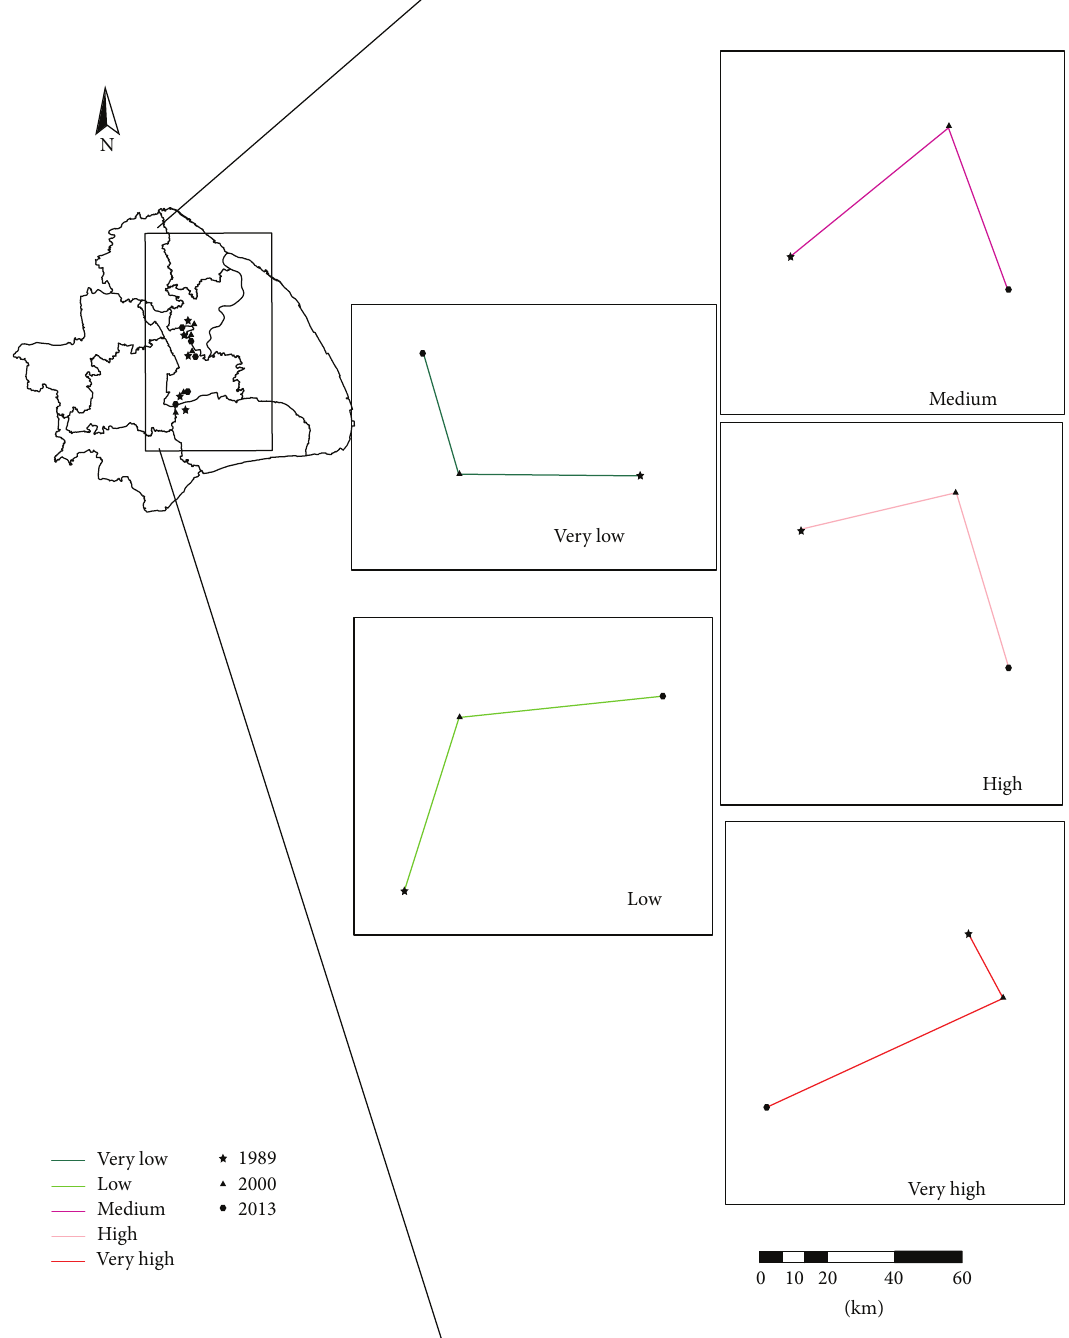
Figure 7: The centroid movement of different LST classes from 1989 to